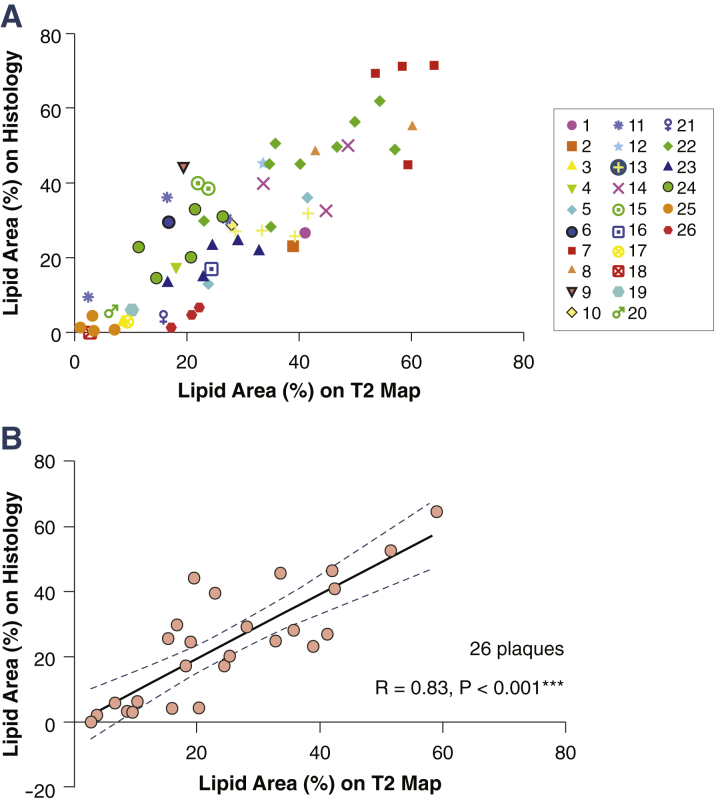
Plaque-by-Plaque Correlation of Lipid Area(A) Scatter plot of lipid area (%) to show slices from the same plaque (individually colored, see legend) tend to contain similar proportions of lipid. (B) Strong correlation maintained with plaque-by-plaque comparison (R = 0.83, p < 0.001). ***p < 0.001.